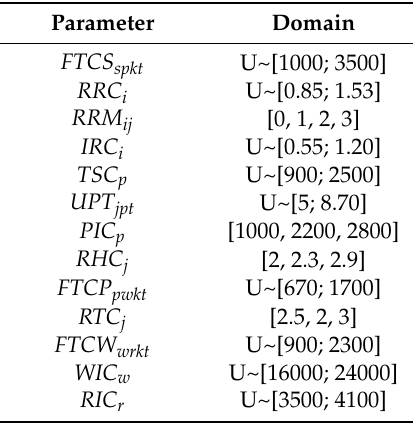
Table A1. Deterministic parameters.